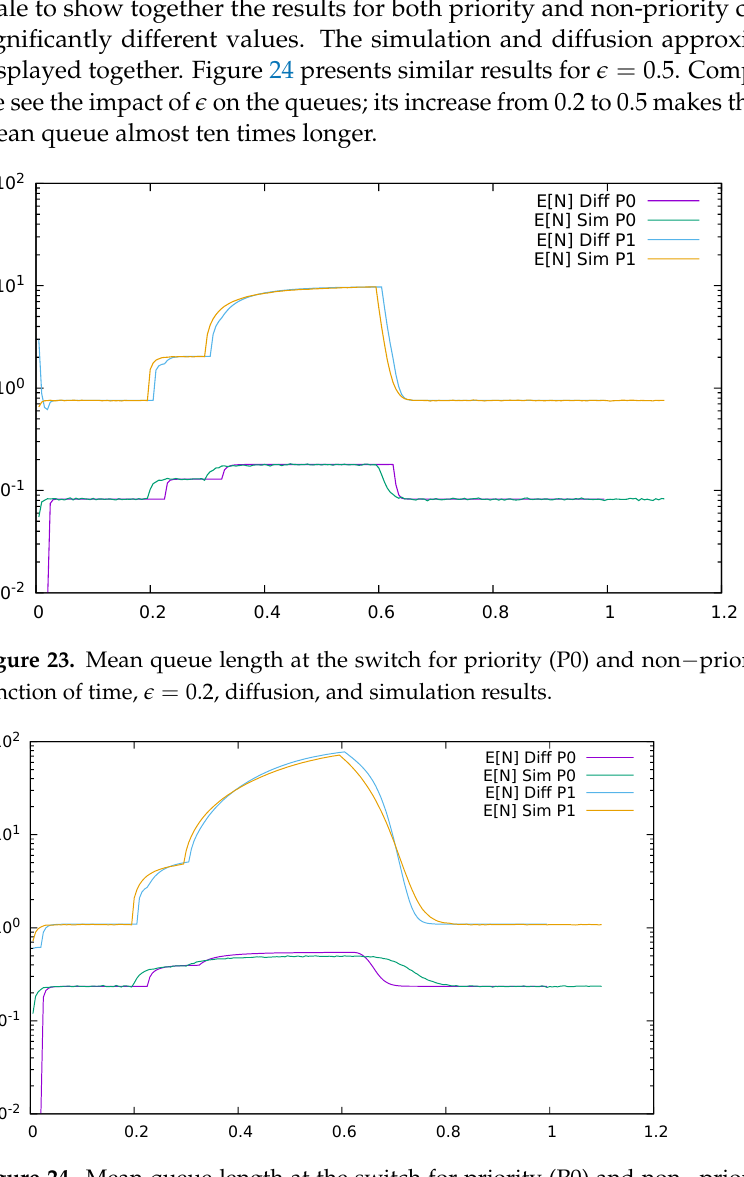
Figure 24. Mean queue length at the switch for priority (P0) and non − priority (P1) packets as a function of time, (cid:101) = 0.5, diffusion and simulation